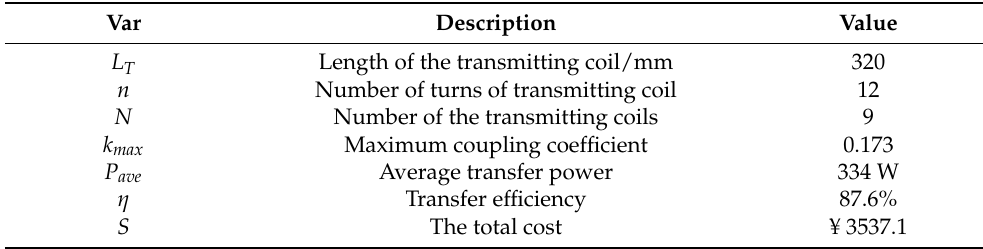
Table 4. Physical parameters of selected point.